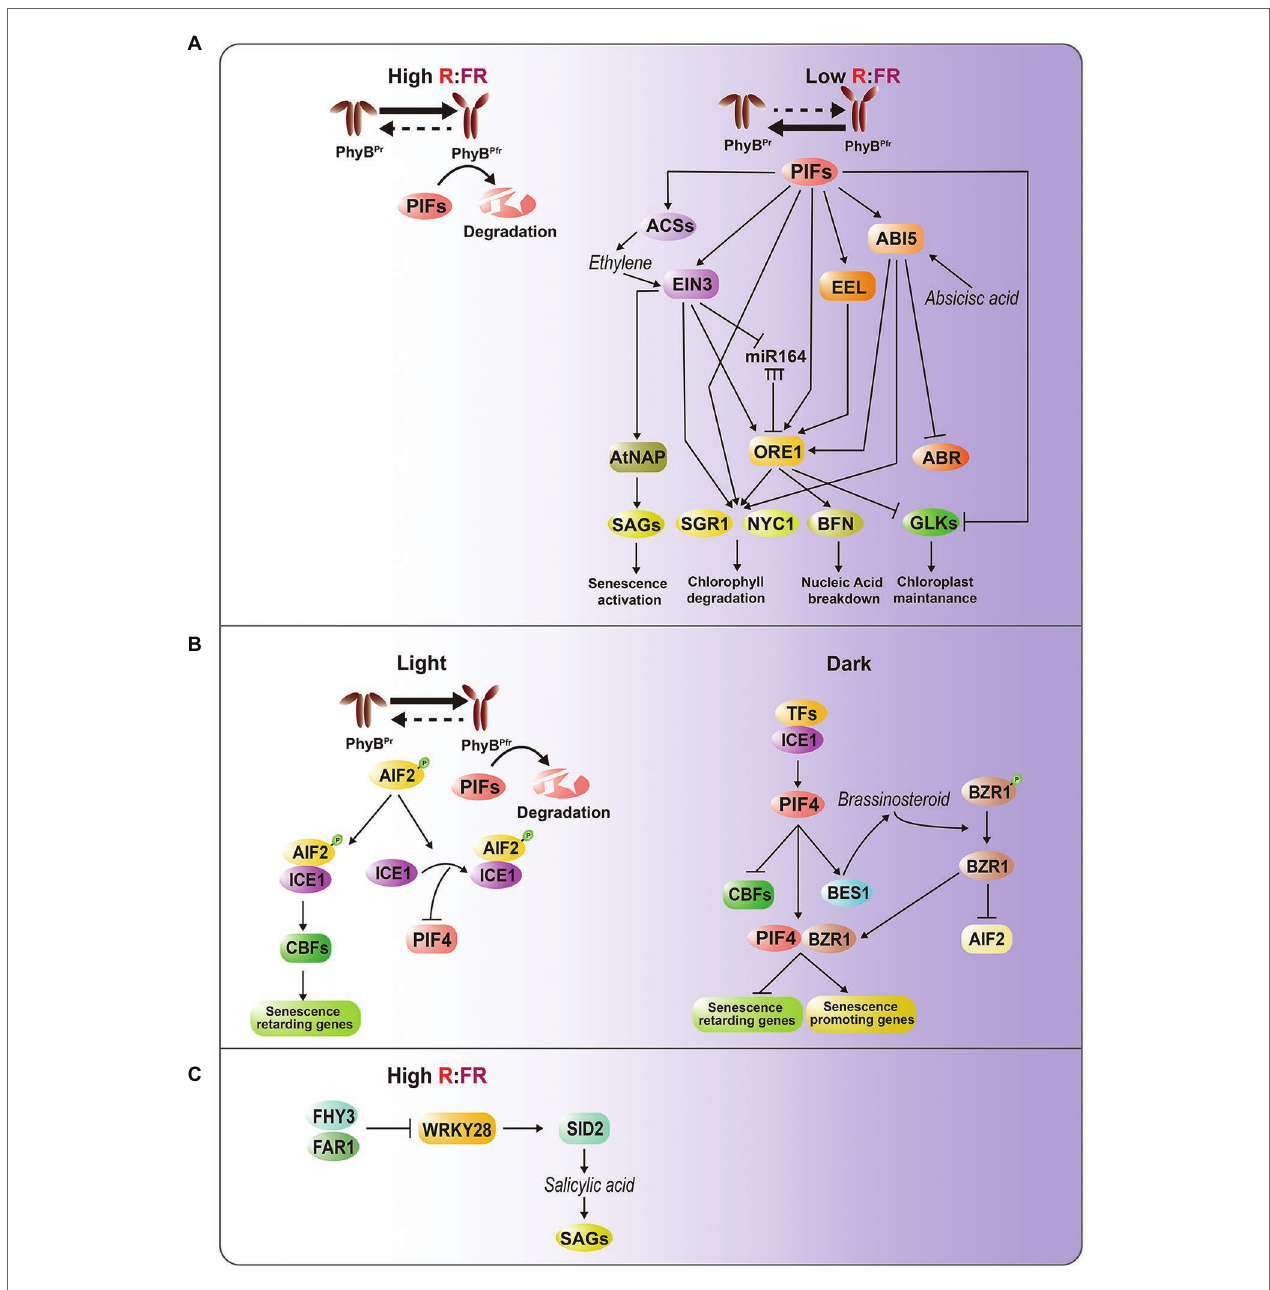
FIGURE 1 | Intricate regulatory interactions between light and hormone signaling pathways in leaf senescence. (A) PhyB-PIFs-mediated senescence regulatory pathways. Under light or high R/FR condition, PIFs are degraded at a phyB-dependent manner, thereby suppressing PIF-dependent senescence activation. Under darkness, shade or low R/FR condition, phyB-mediated PIF degradation is inhibited, leading to activation of senescence-promoting ABA and ethylene hormone pathways. Direct targets of PIFs include EIN3 for ethylene signaling, and ABI5 and EEL for ABA signaling. Moreover, PIFs, EIN3, ABI5, and EEL activate ORE1 , one of master regulators in leaf senescence, through binding to its promoter. Accumulating ORE1, PIFs, ABI5, and EIN3 subsequently activate SGR1 and NYC1 for chlorophyll degradation, whereas ORE1 alone induces BFN for nucleic acid degradation and other SAGs. On the other hand, PIFs and ORE1 repress the chloroplast maintenance master regulator GOLDEN2-LIKE (GLK) by suppressing its promoter activity and sequestrating protein through protein-protein interaction, respectively. EIN3 also regulates ORE1 through miRNA164 , and directly activates AtNAP , another senescence master regulator. ABI5 suppresses ABR . (B) AIF2-ICE1-mediated retardation of dark-induced senescence. PIFs are also involved in dark- and BR-induced leaf senescence at phyB-independent manner. In light, AIF2 interacts with ICE1 to directly downregulate PIF4 and upregulate CBFs , which promote self-maintenance or senescence-repressing genes. In darkness, PIF4 promotes BR synthesis and BZR1 activation, leading to decrease of AIF2. Activated BZR and PIF4 complex suppresses senescence-retarding genes and activates senescence- promoting genes. (C) FHY3-WRKY28 transcription module involved in interlinking between light and salicylic acid pathways. High R/FR condition activates FHY3 and FAR1 , subsequently suppressing WRKY28 , which promotes SA